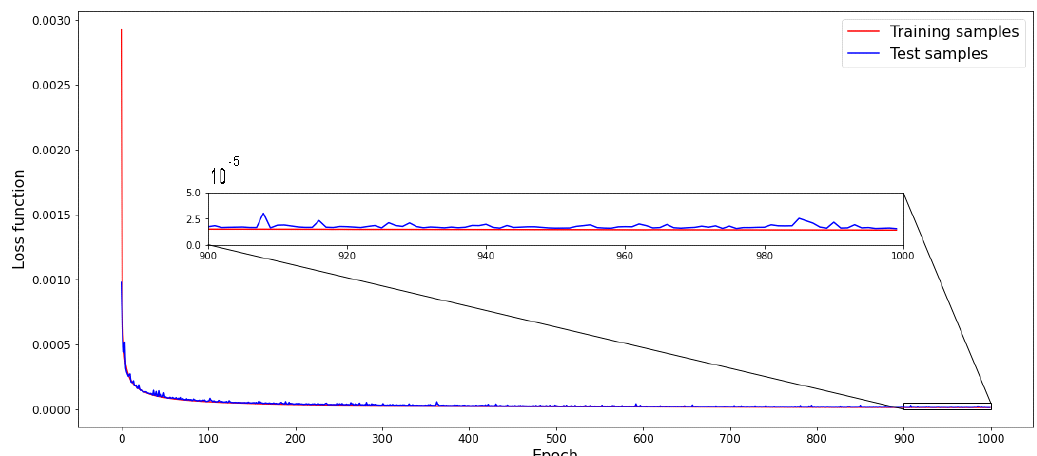
Figure 3. Profile of function loss values for the training and test datasets along epochs for a 4-layer model with 280 nodes per layer.